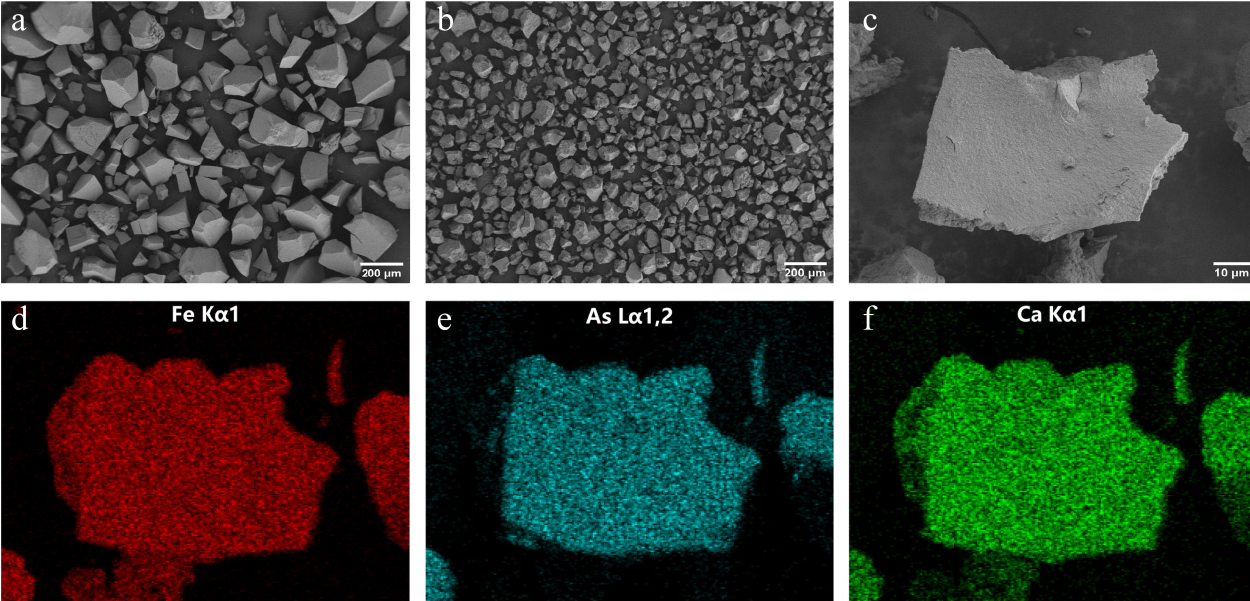
Figure 1. Initial XRD patterns ( a ) and FTIR spectra ( b ) of Fh, As-Fh, and As-Ca-Fh.